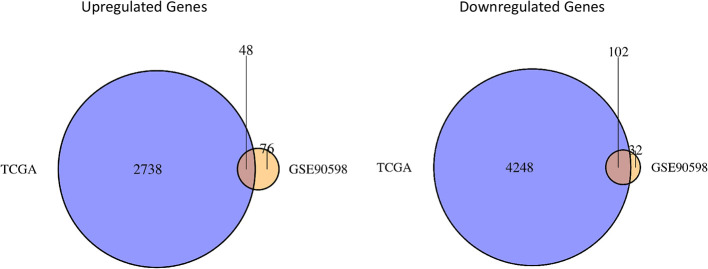
Venn diagrams of differential gene sets. The Venn diagrams show the crossed genes shared by TCGA and GSE90598 glioma datasets. Left panel represents the intersection of two upregulated gene lists, whereas the right panel represents the intersection of two downregulated gene lists. 48 oncogenic genes and 102 suppressor genes are identified in the intersections.